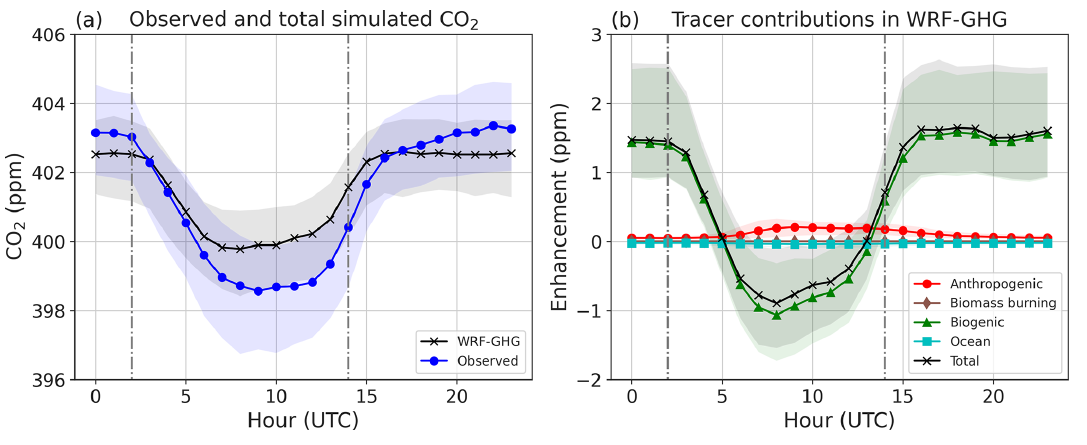
Figure 14. Same as Fig. 7 but for Maïdo.